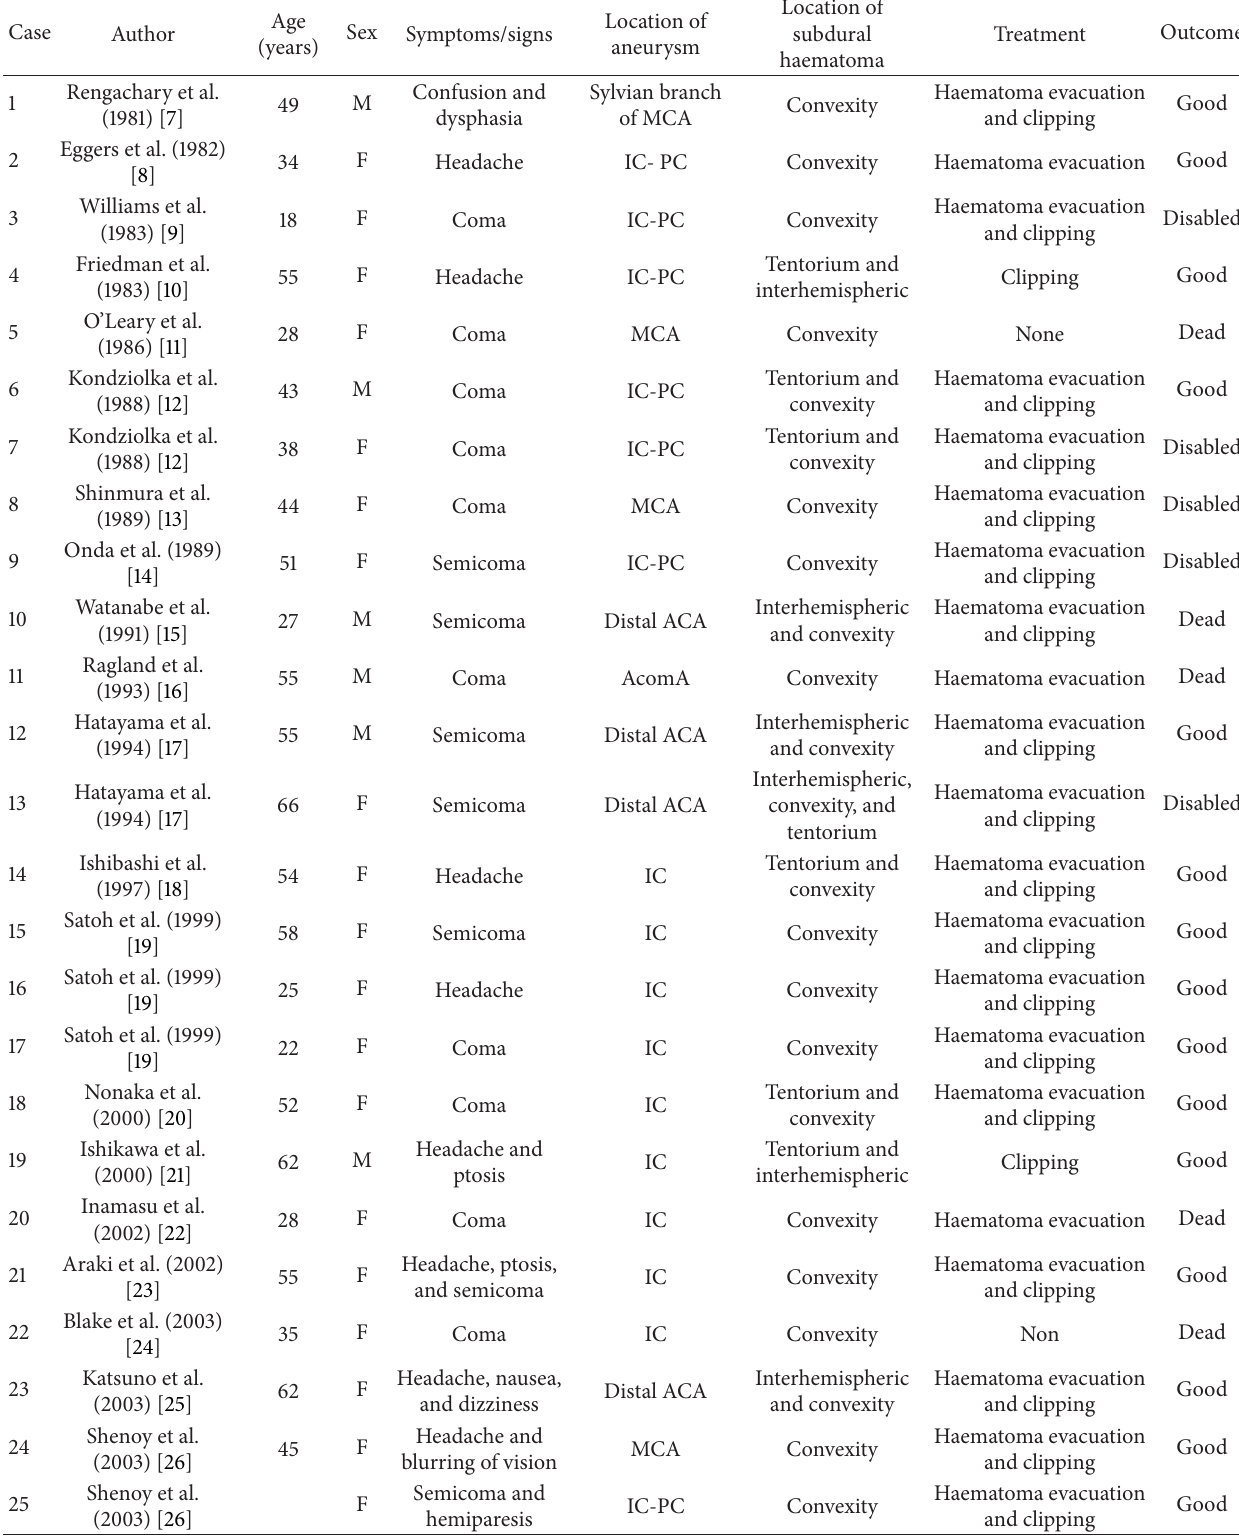
Table 1: Cases of pure subdural haematoma (without subarachnoid haemorrhage and without intraparenchymal haematoma) caused by rupture of intracranial aneurysm [5,